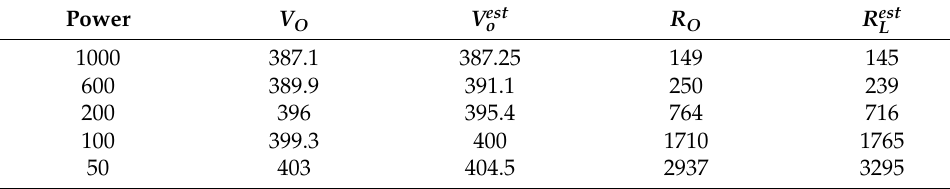
Figure 16. Experimental results, P O = 200 W. Table 3. Experimental results